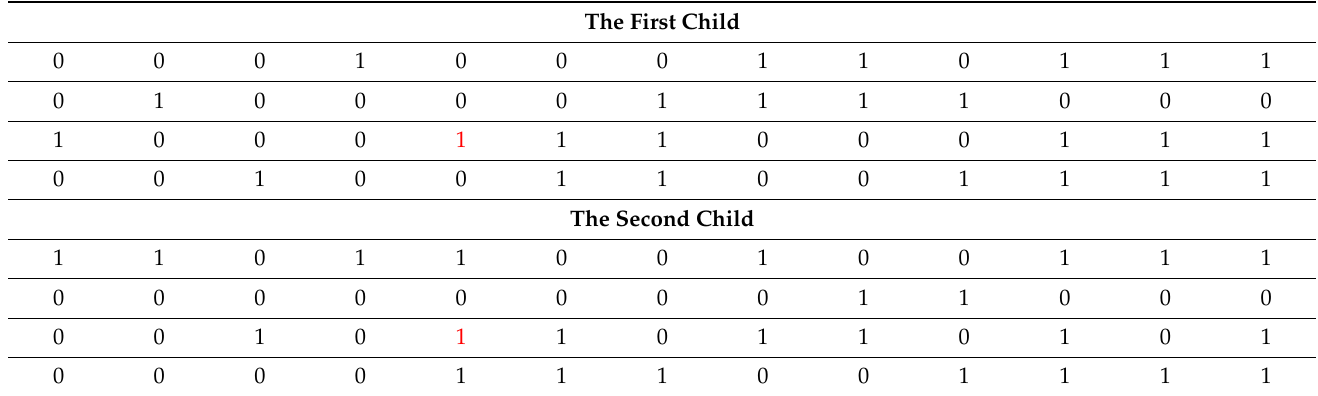
Table 7. Children of the cross-array operator.